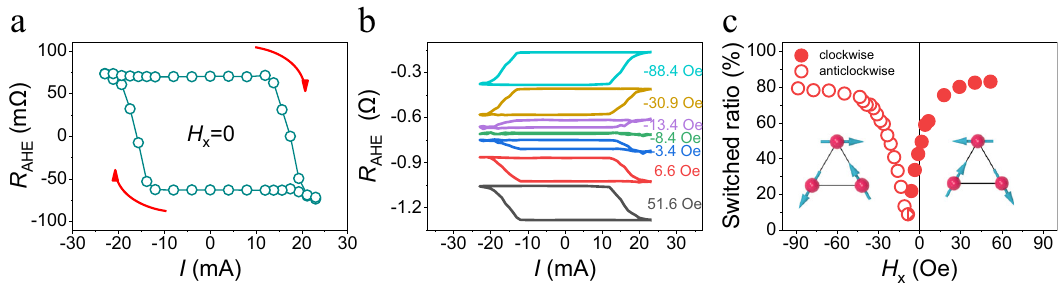
underdifferentmagnetic fi elds.Herethedirectionofmagnetic fi eldisin-planeand parallel to the current. The two opposite Mn 3 Sn domains contribute opposite z spins and thus induce clockwise and anticlockwise switching polarity as indicated as solid and hollow dots.